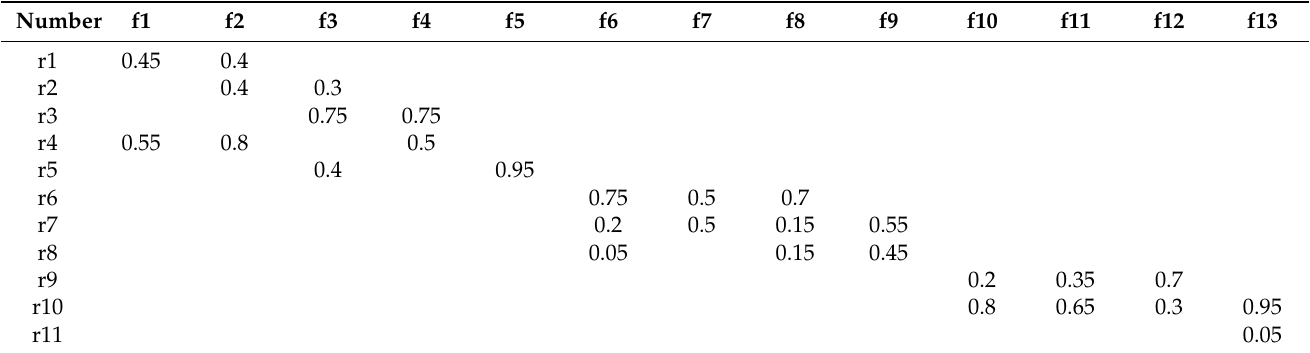
Table 5. The relation table between fault reasons and features of SF6 circuit